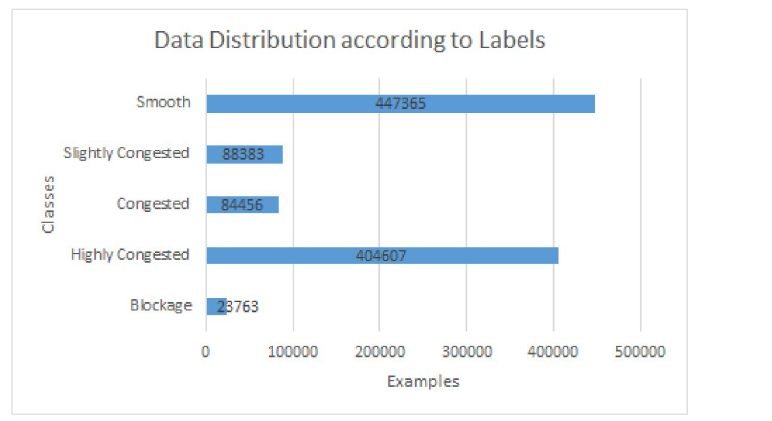
Fig 2. Data distribution according to